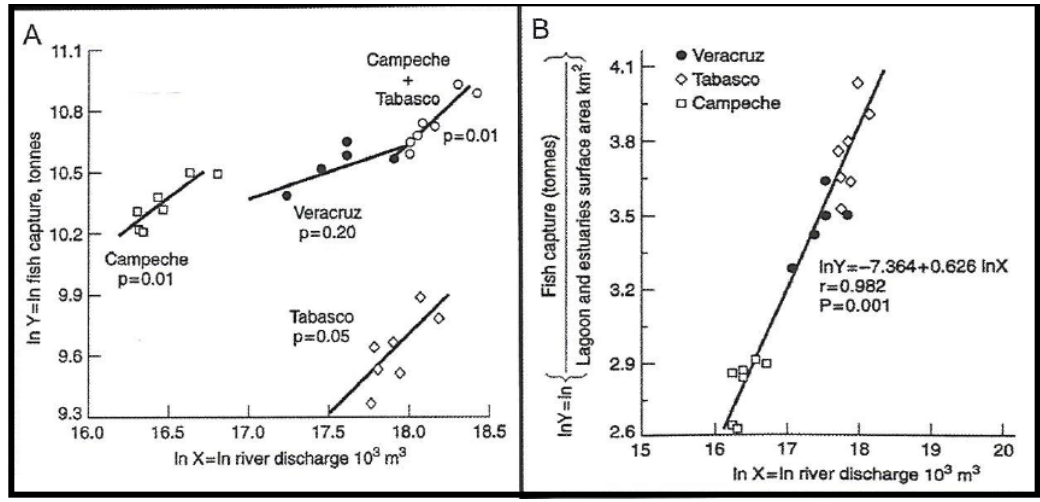
Figure 2. Relationships between river discharge and ( A ) annual fish landings in the Mexican states of Veracruz, Tabasco and Campeche and river discharge; and ( B ) normalized to the surface area of estuaries, as shown in Baltz and Yáñez-Arancibia [31].